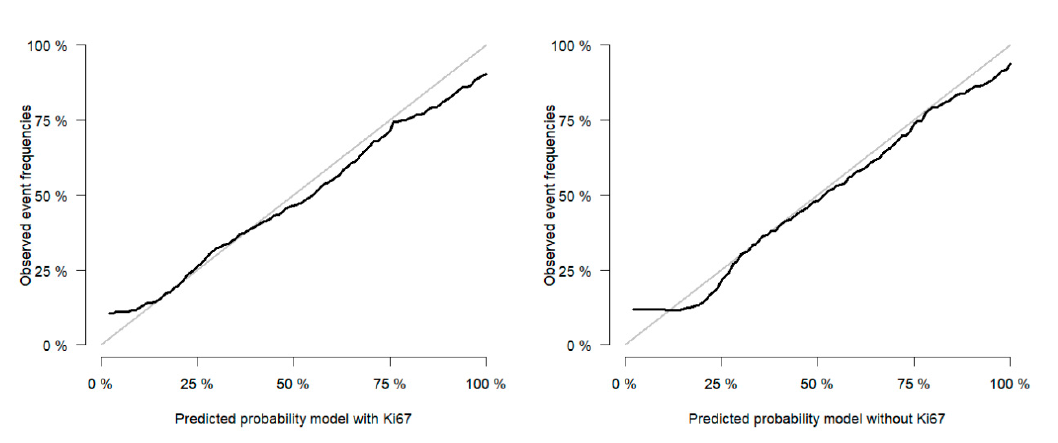
Figure 2. Months of follow-up time.